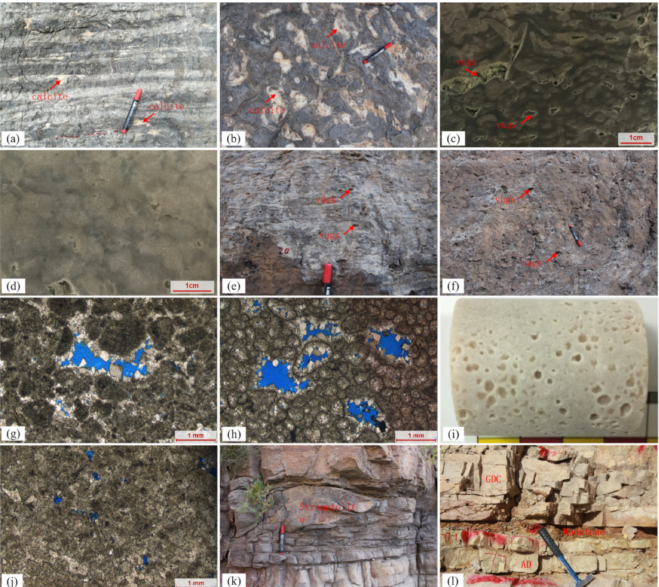
Figure 3. Photographs of dolomite in Xiaoerblak Formation: ( a ) laminated microbial dolomite, with alternating microwave bright and dark laminae, vugs filled with sparry calcite are developed along the bedding, member Xi 1, outcrop image; ( b ) Laminar dolomite (vertical perspective), member Xi 1, outcrop image; ( c ) Thrombolite dolomite, irregular layered structure, submember Xi 2 1 , sample section image; ( d ) Layered thrombolite dolomite, bedding vugs are uniformly distributed, submember Xi 2 1 , sample section image; ( e ) Thrombolite dolomite, reticular structure, submember Xi 2 2 , outcrop image; ( f ) Massive thrombolite dolomite, bedding vugs are uniformly distributed, submember Xi 2 2 , outcrop image; ( g ) Grain dolomite, with microbial bonding structure and a small amount of dissolved pores between grains, submember Xi 2 3 , blue casting thin section PPL image; ( h ) Foamy microbial dolomite, with fenestral dissolved pores, submember Xi 2 3 , blue casting thin section PPL image; ( i ) Foamy microbial dolomite, subround fenestra pores are uniformly distributed, submember Xi 2 3 , plug sample image; ( j ) Crystalline dolomite remaining grain apparition, with intercrystalline dissolved pores, submember Xi 2 3 , blue casting thin section PPL image; ( k ) Stromatolite